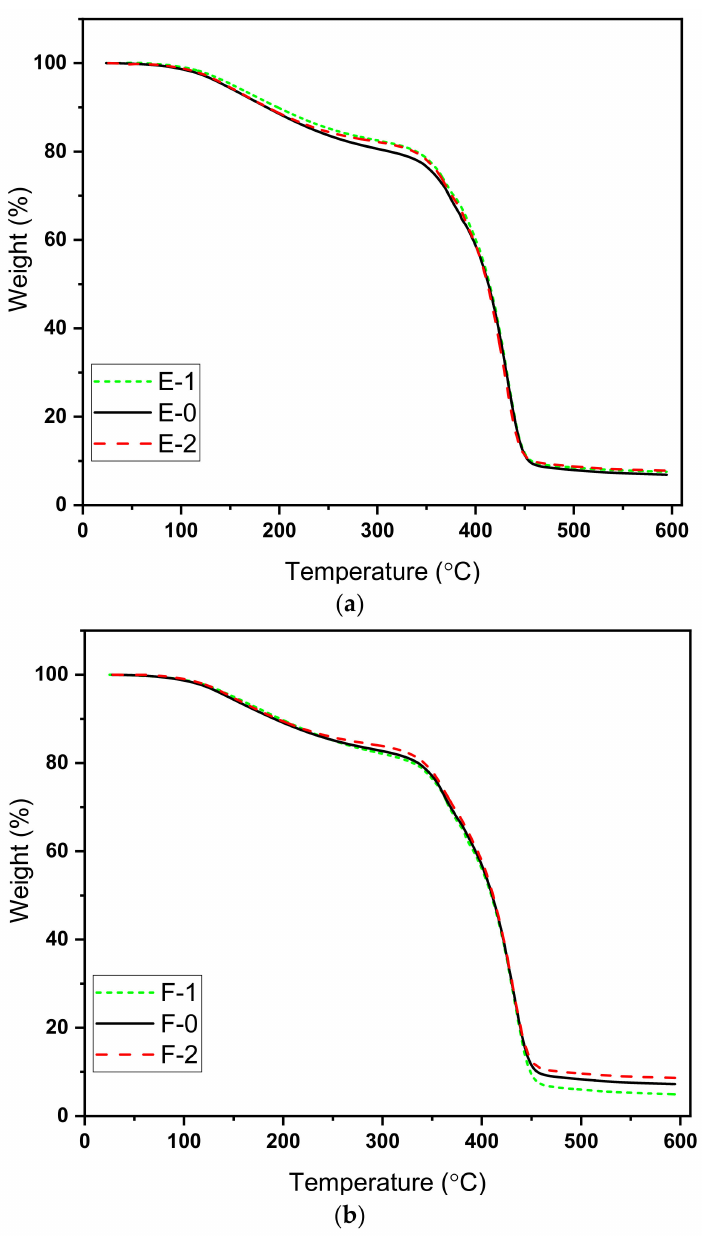
Figure 4. TGA curves for prepared samples ( a ) Hardener 450-BD with variation in hardener percentage ( b ) Hardener 3282-1 BD with variation in hardener